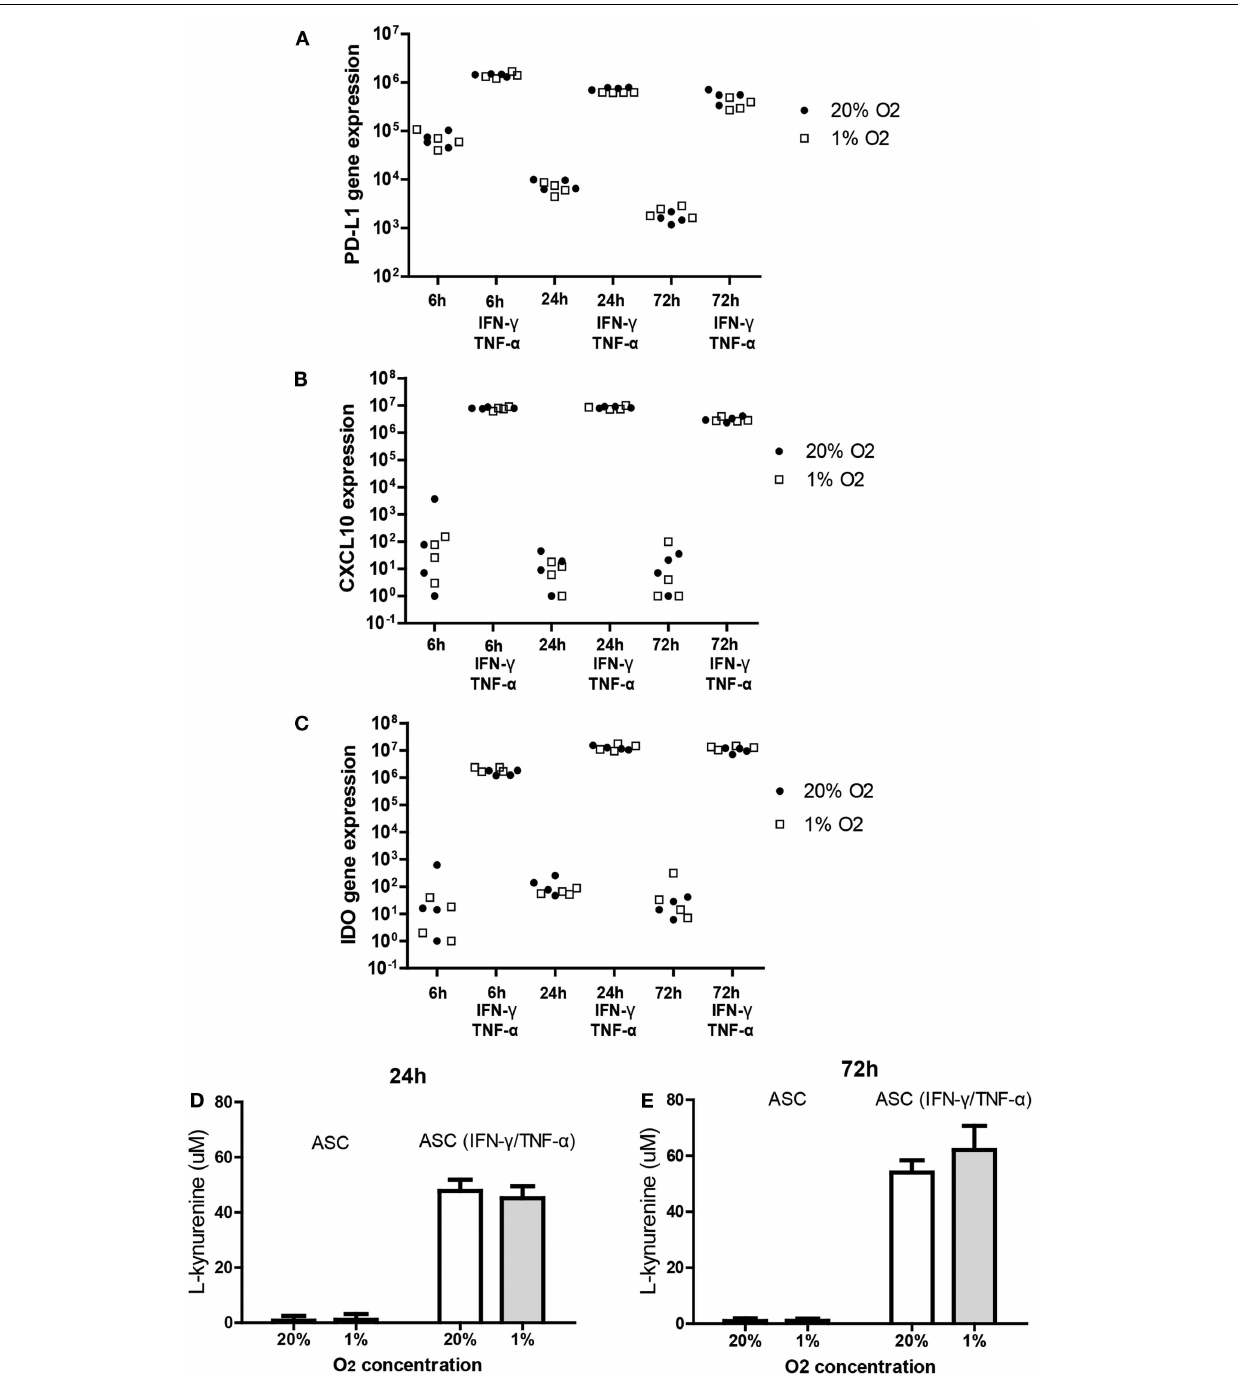
FIGURE 3 | Effect of hypoxia on the induction of PD-L1 (A), CXCL-10 (B), and IDO (C); mRNA expression inASC after IFN- γ /TNF- α stimulation . ASC were cultured under 20 or 1% O 2 for 6, 24, or 72h with or without 50ng/ml IFN- γ and 20ng/mlTNF- α . Every data point represents